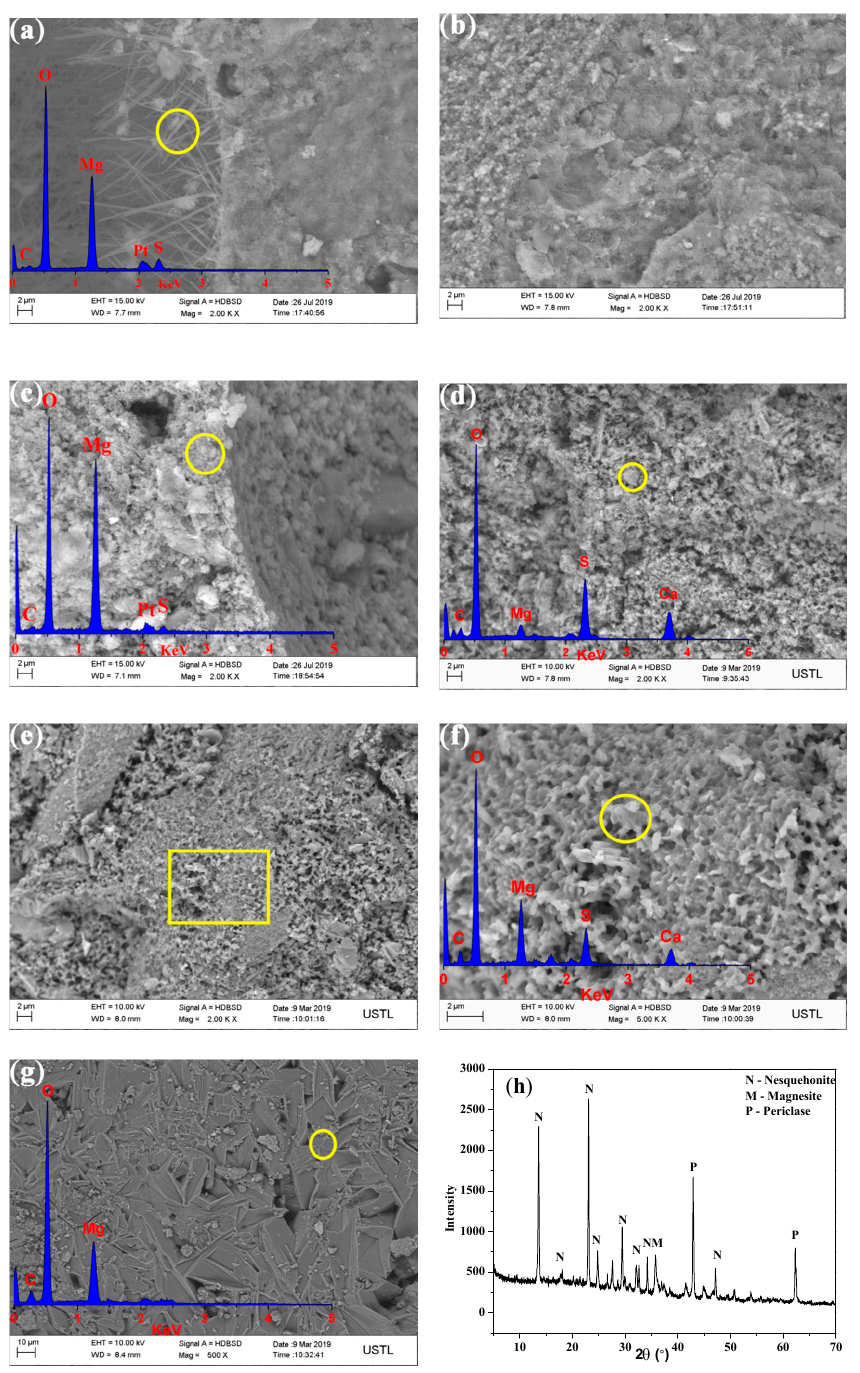
Figure 11. Fractured surface morphology of samples after 28 days curing: ( a ) pore of control with CO 2 treatment; ( b ) matrix of control with CO 2 treatment; ( c ) pore of SS30 with air curing; ( d ) matrix of SS30 with air curing; ( e , f ) matrix of SS30 with CO 2 treatment; ( g ) surface of control with CO 2 treatment; and ( h ) XRD pattern of the surface of the control with CO 2